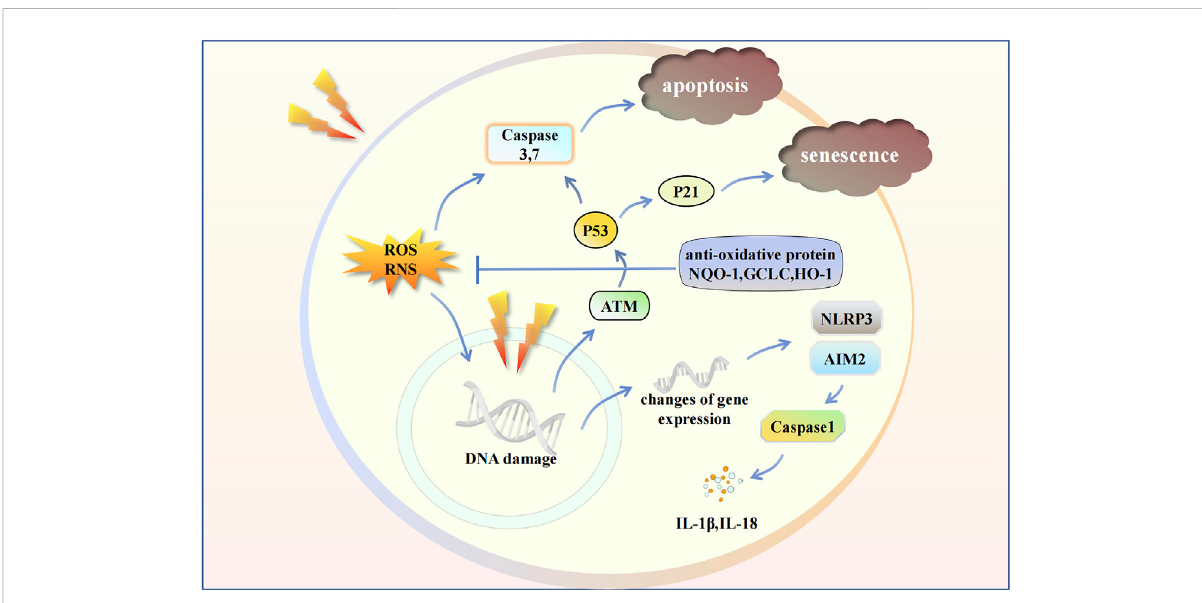
FIGURE 2 Radiation in fl uencessomeintracellular signaling pathways inendothelial cell.Radiationleadsto thechanges in geneexpressionand damage in gene structure. ROS and RNS cause apoptosis. In fl ammasomes induce the release of cytokines. The activation of ATM/P53/P21 signaling pathway cause cell senescence. IL, Interleukin; ATM, Ataxia telangiectasia mutated; P21, Cyclin-dependent kinase inhibitor 1A; NQO-1, NAD(P)H Quinone Dehydrogenase 1; GCLC, Glutamate-Cysteine Ligase Catalytic Subunit; HO-1, Heme